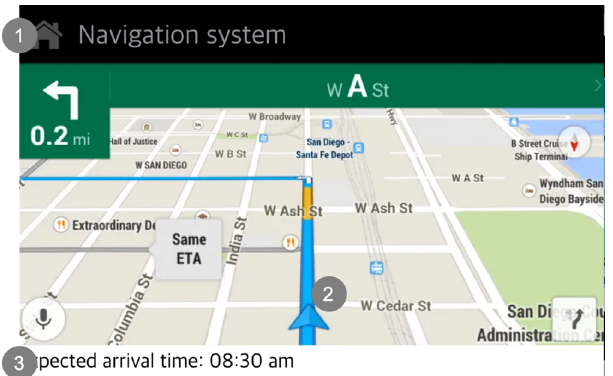
Figure 7. Descriptions of the main screen of the current telematics system (Source: Own creation): ( 1 ) The current telematics system presents the navigation route guidance; ( 2 ) It presents the navigation